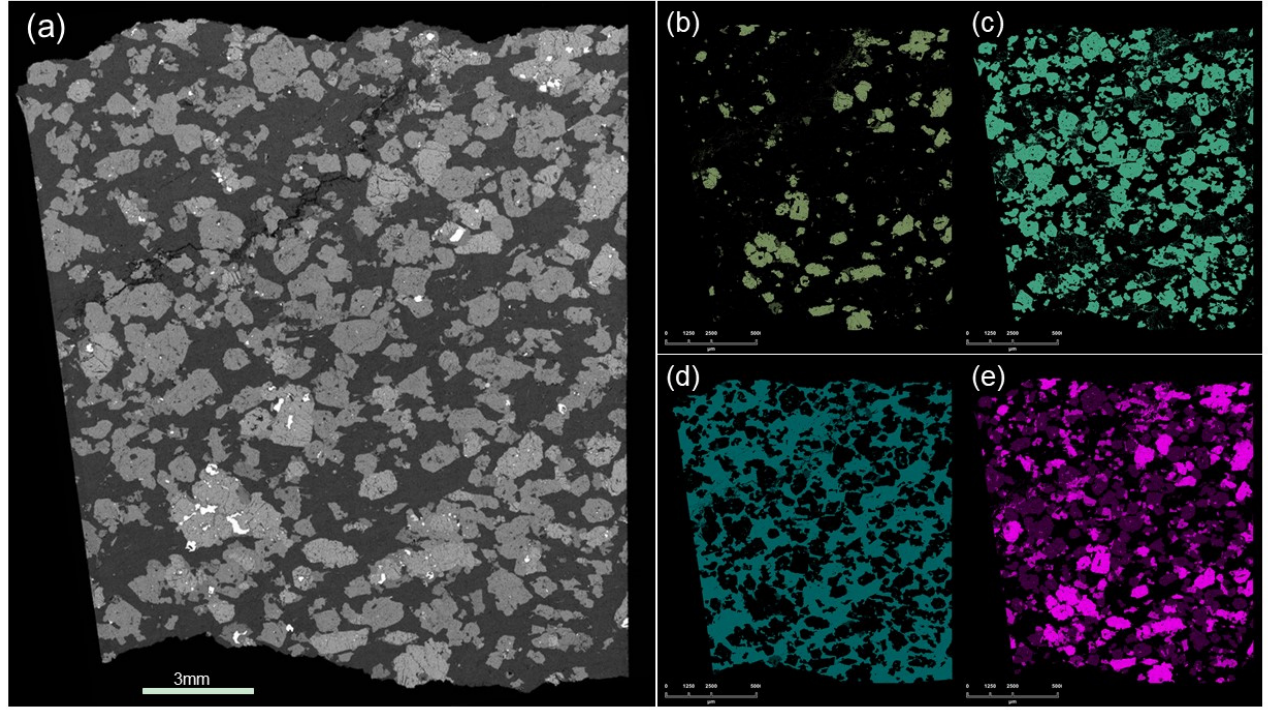
Figure 3. The mineralogy of CR-1. ( a ) Backscattered electron image of CR-1. ( b – d ) The distribution of olivine, pyroxene, and plagioclase. ( e ) The distribution of calcium of CR-1. Different grayscale shows different mineral phases.